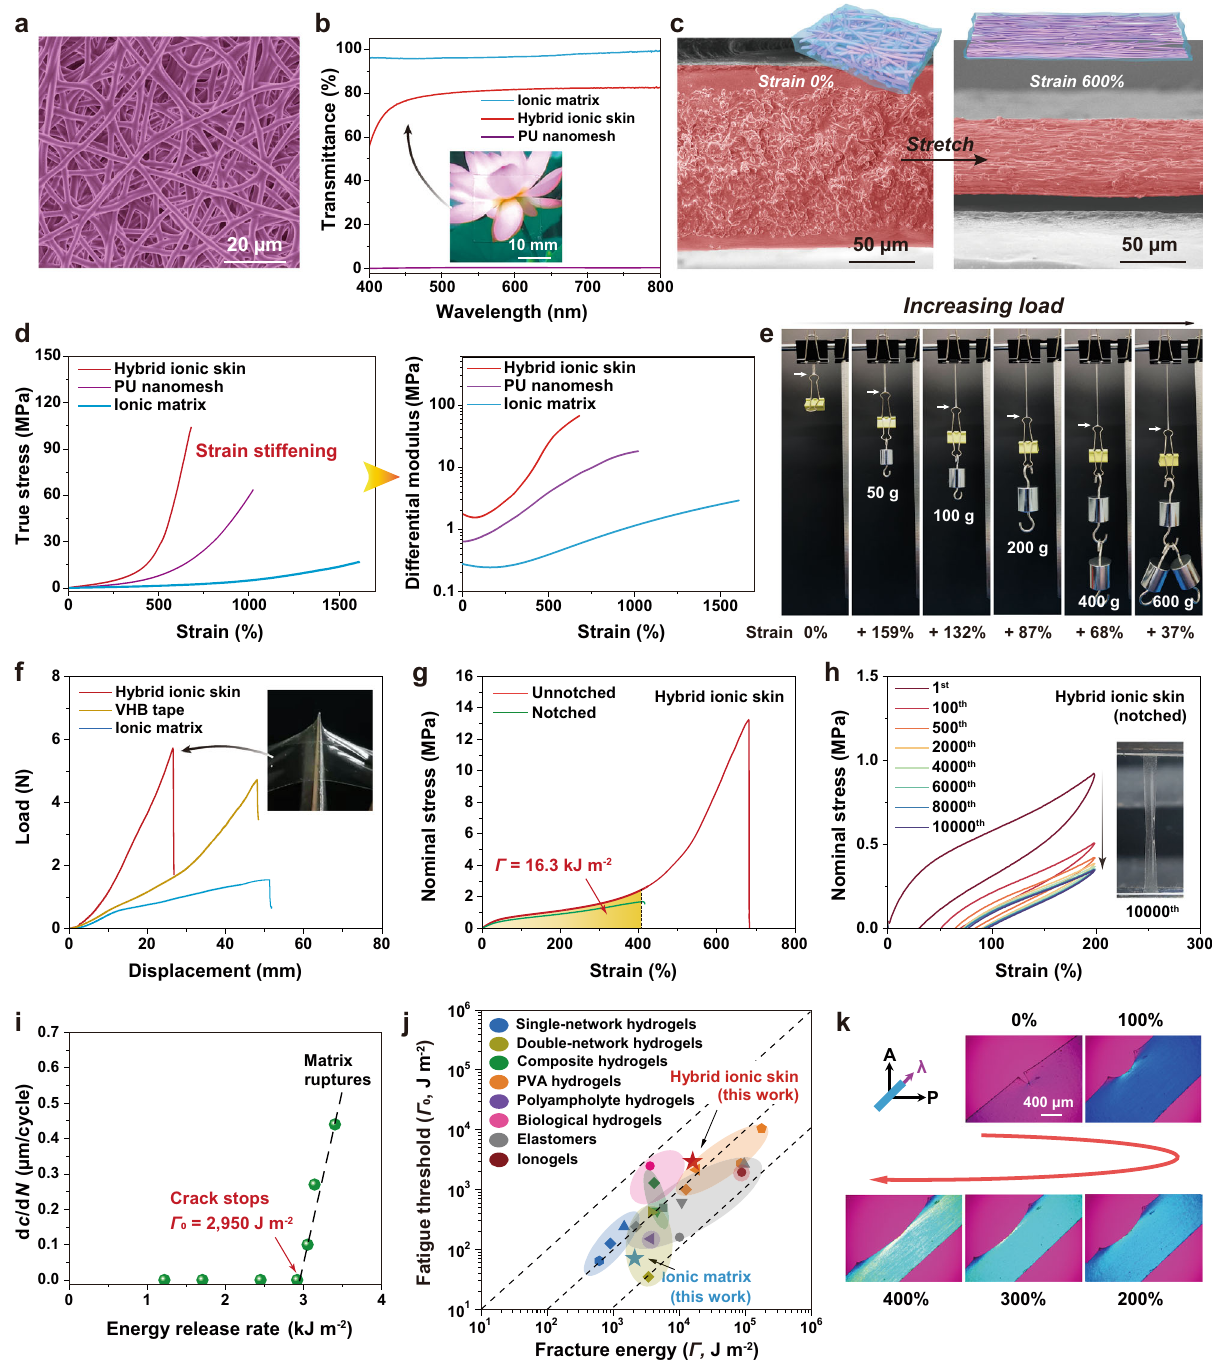
Fig. 2 | Morphology and mechanical properties of hybrid ionic skin. a SEM image of self-healing PU nanomesh. b Transmittance of hybrid ionic skin, PU nanomesh, and ionic matrix. c Cross-sectional SEM images of hybrid ionic skin before and after stretching. d True stress-strain and corresponding differential modulus curves. e Strain-stiffening demonstration of a hybrid ionic skin strip (15×3×0.13mm 3 ) with increasing loads. f Puncture force-displacement curves of hybrid ionic skin (thickness ~130 μ m), ionic matrix (1mm), and commercial VHB (Very High Bond) tape (0.5mm). g Nominal stress-strain curves of unnotched and